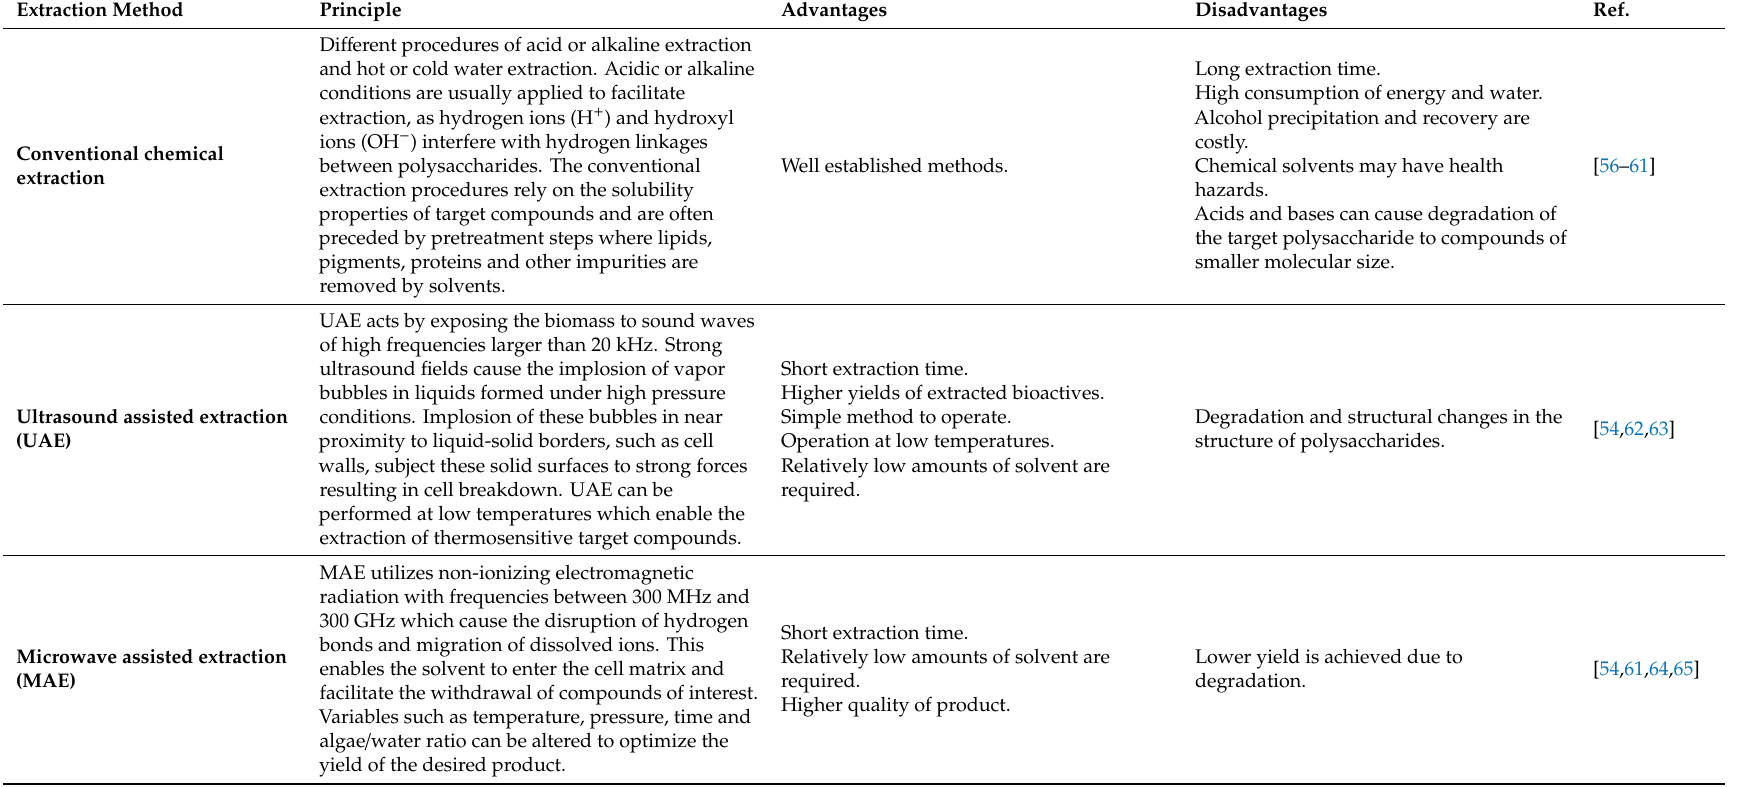
Table 2. Overview of extraction